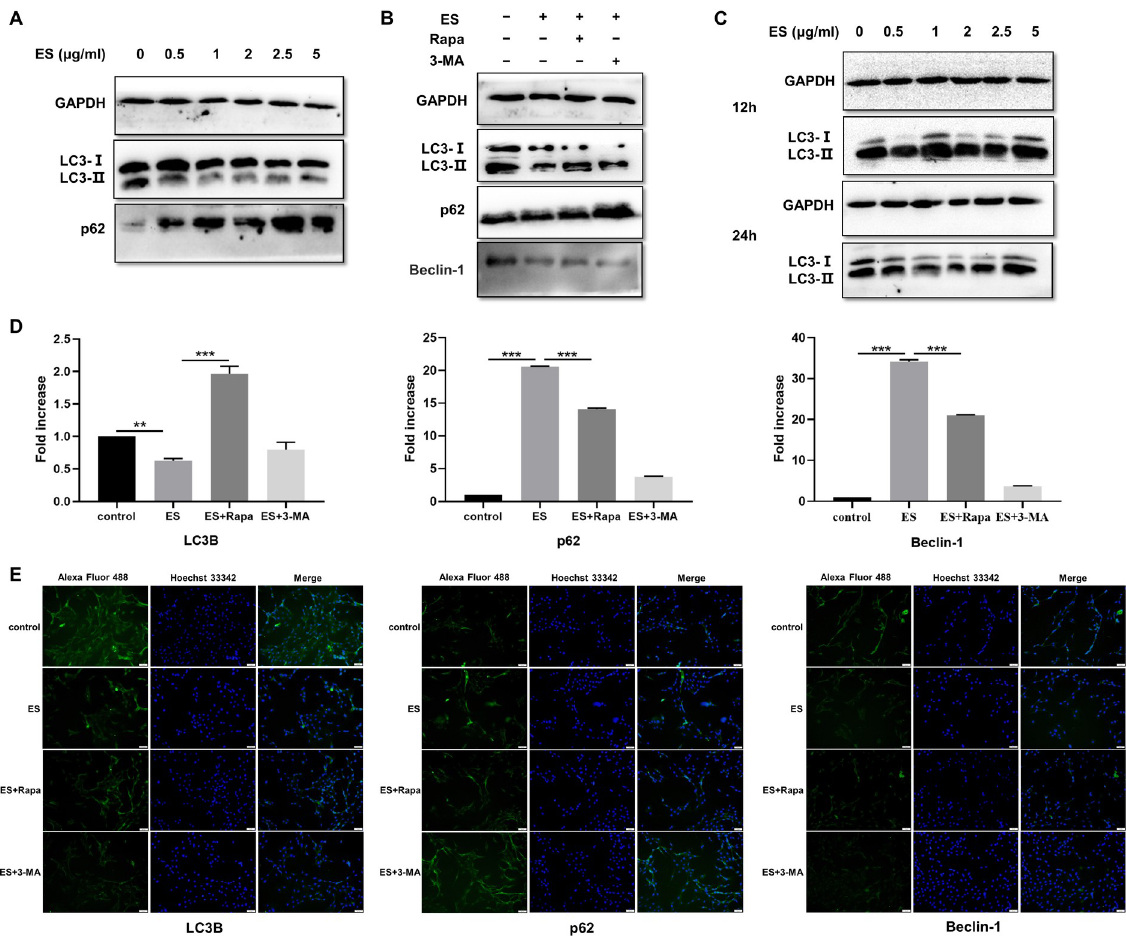
Fig 6. Protein level and transcriptional level of LC3B, p62, and Beclin-1 in ES-treated myoblasts. A. The protein expression level of LC3B and p62 in myoblasts treated with 0, 0.5, 1, 2, 2.5, and 5 μ g/ml ES for 3 h. B. The protein expression level of LC3B and p62 in myoblasts treated with or without 1 μ g/ml ES, rapamycin (100 nM), and 3-MA (5 mM) for 3 h. C. The protein expression level of LC3B and p62 in differentiated myoblasts treated with 0, 0.5, 1, 2, 2.5, and 5 μ g/ml ES for 12 h or 24 h. D. Expression of LC3B, p62, and Beclin-1 mRNA in myoblasts treated with or without 1 μ g/ml ES, rapamycin (100 nM), and 3-MA (5 mM) for 3 h. E. Immunofluorescence stained with LC3B, p62 and Beclin-1 antibodies in myoblasts treated with or without 1 μ g/ml ES, rapamycin (100 nM), and 3-MA (5 mM) for 3 h (magnification, 400 × ). The data represent at least 3 independent experiments and are expressed as mean ± SD. p < 0.05( � ), p < 0.01( �� ), p < 0.001( ���